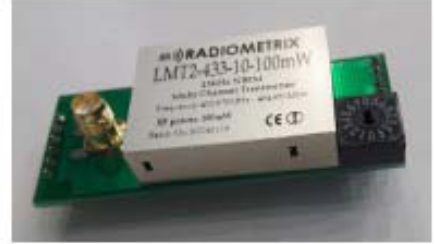
Figure 9. Circuit board with the Radiometrix TM USX2 module for generating EM carrier waves at 433MHz.